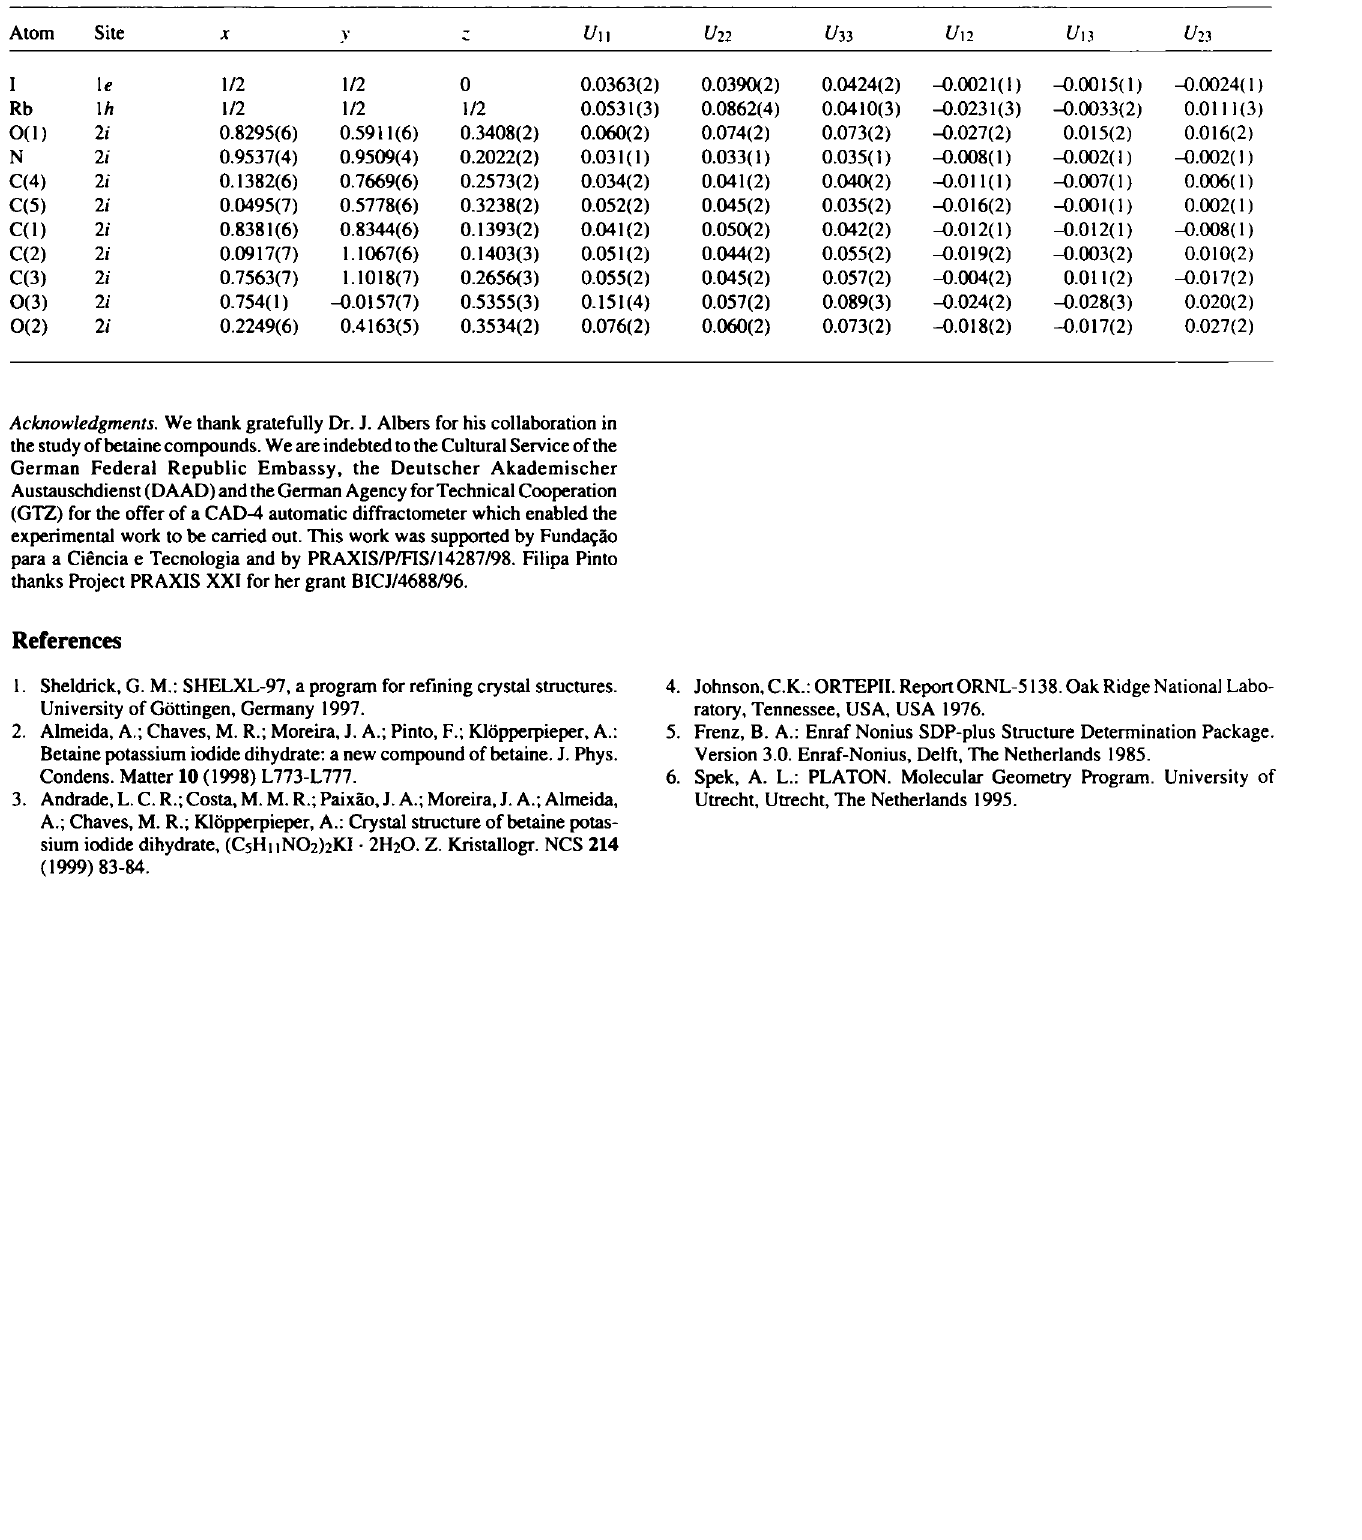
Table 3. Atomic coordinates and displacement parameters (in A 2